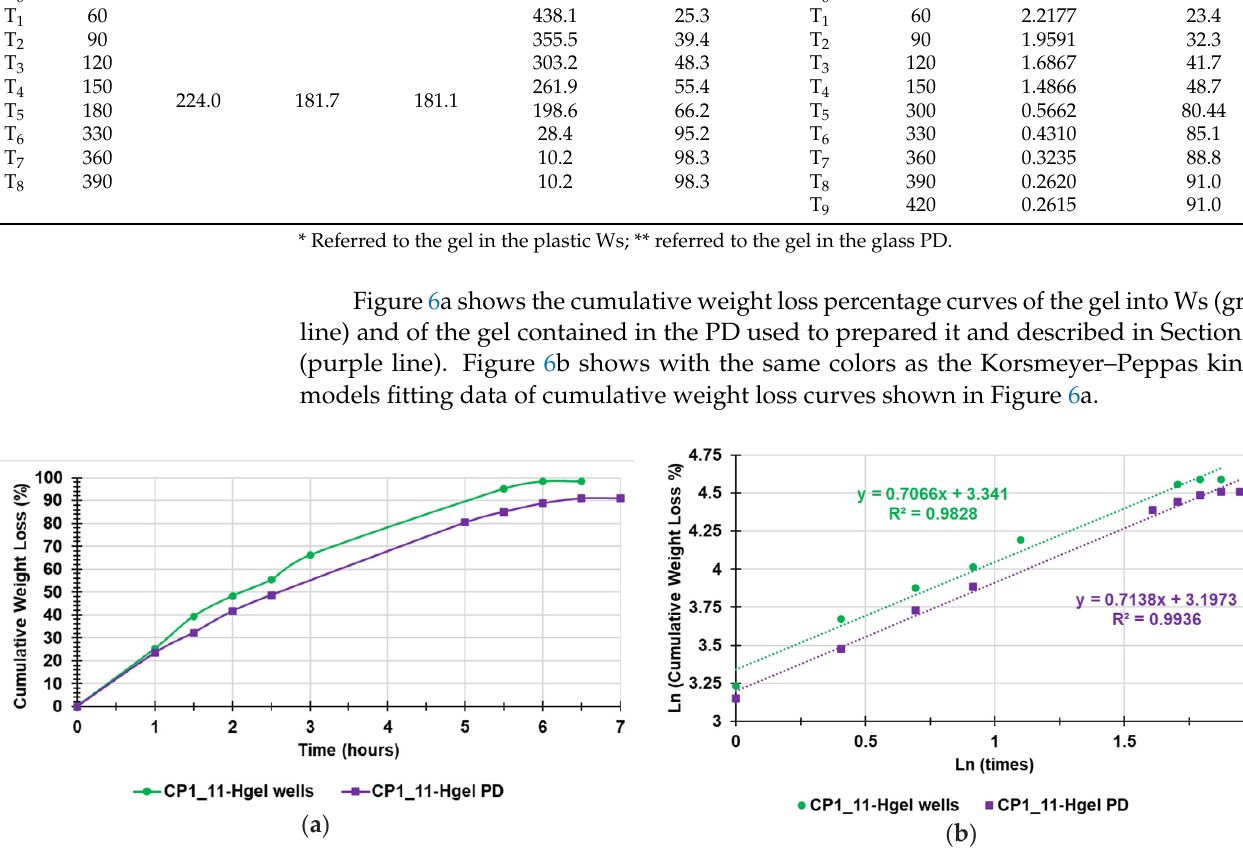
Table 2. Weights of gels in Ws and in the PD determined at times T 0 –T x .